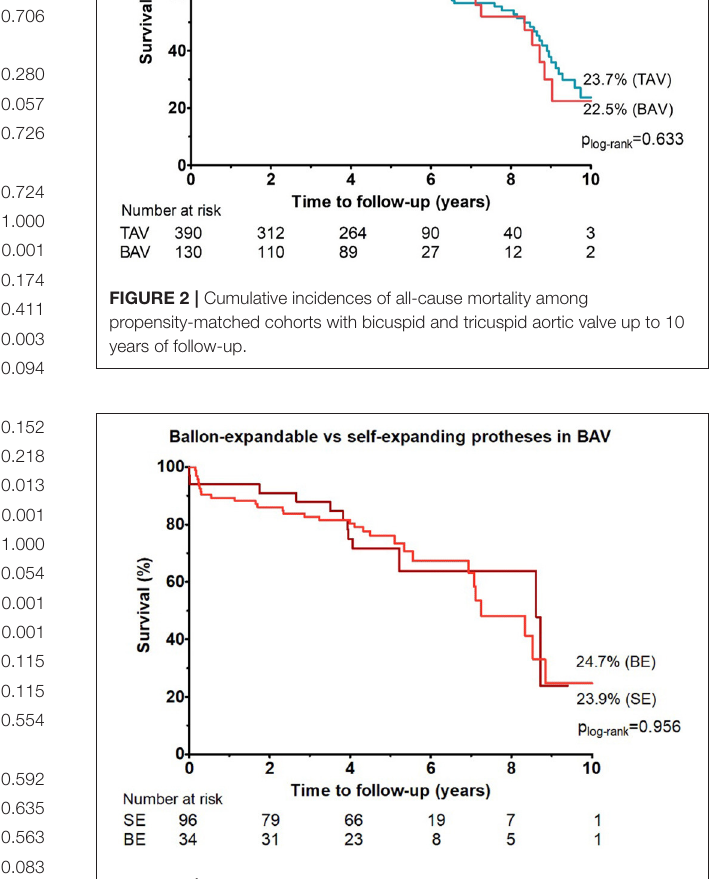
FIGURE 3 | Cumulative incidences of all-cause mortality up to 10 years of follow-up among patients with bicuspid aortic valve who received balloon-expandable vs. self-expanding